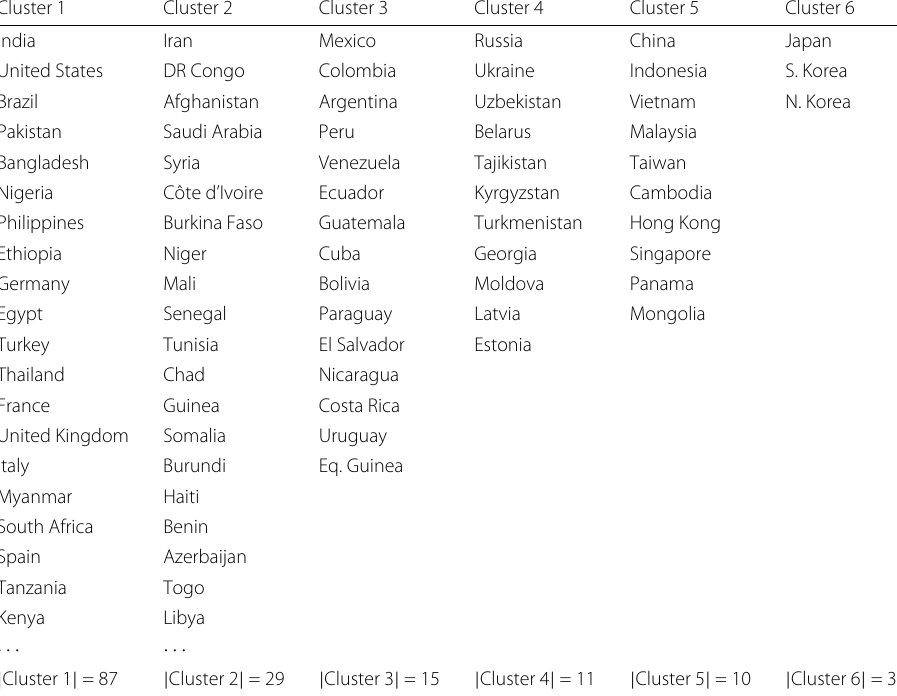
Table 3 Clustering the territories from the U NICODE -L ANGUAGES network using the mean-weighted collider motif Cluster